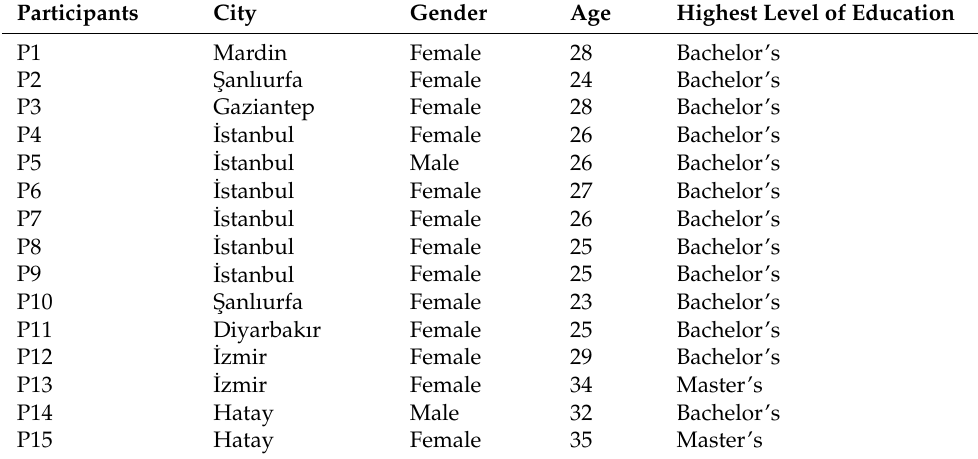
Table 1. Characteristics of